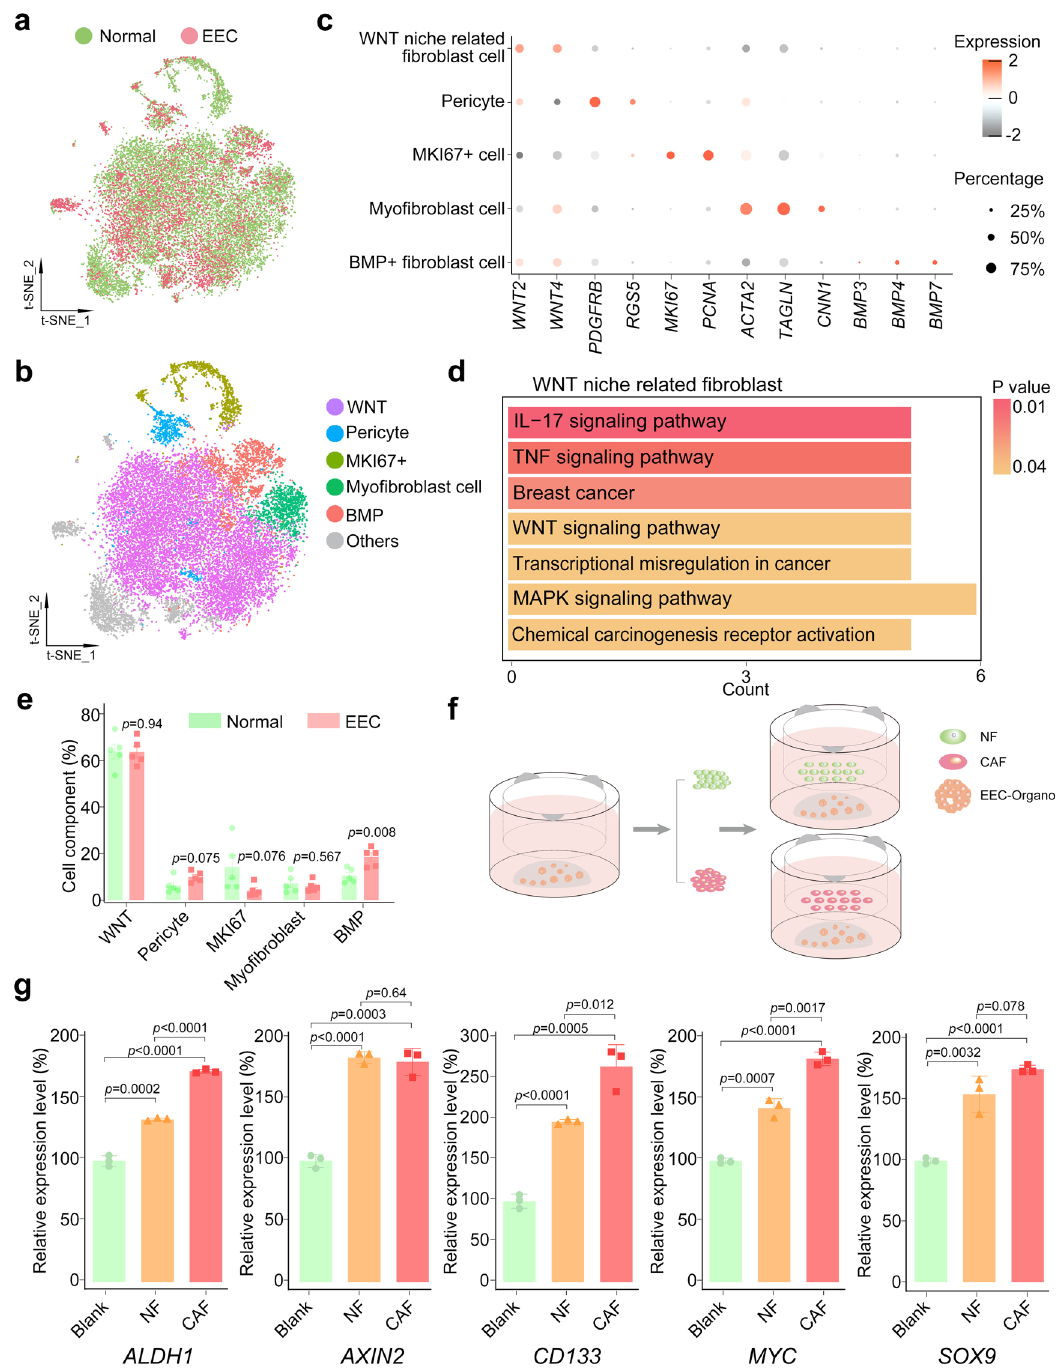
Fig. 6 | Converted stromal fi broblasts establish oncogenic signal niche for endometrial epithelium. a t-SNE plot of stromal fi broblast from normal and EEC samples. b t-SNE plots of indicated cell-type clusters of stromal fi broblast cells. c Expression patterns of canonical markers of fi broblast cell types. Each dot represents a gene, of which the color saturation indicates the average expression level, and the size indicates the percentage of cells expressing the gene. d KEGG enrichment analysis of differential expression genes between WNT niche-related fi broblast cells and others was enriched in Wnt signaling pathway. P -values are analyzedbyFisher ’ sexacttest,one-sided. e Thepercentageofdifferentcell-typeof stromal fi broblast showing in ( b ) between normal and EEC samples. Data are mean±SEM based on fi ve independent biological replicates (Source data are provided as a Source Data fi le). P -value was analyzed by t -test, two-sided. P values